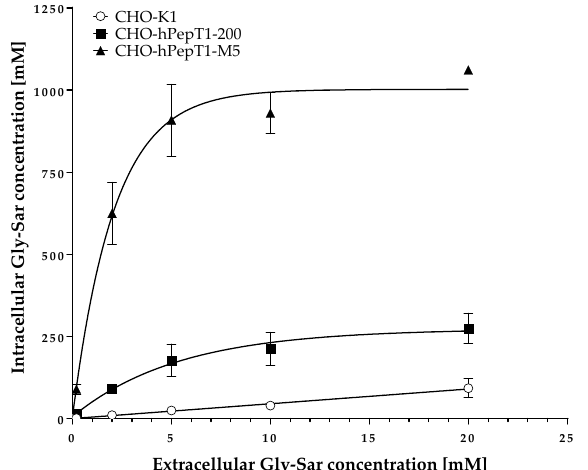
( b ) Figure 4. Concentration-dependent inhibition of the Gly-Sar uptake in the CHO-hPepT1-M5 ( a ) and the CHO-hPepT1-200 ( b ) clone by losartan. The data points represent the mean ± S.E.M. of three independent experiments with each concentration tested in sextuplets. Therefore, we used the M5 clone for all subsequent experiments and verified its PepT1 activity via inhibition with a second inhibitor (Gly-Pro). As observed with losartan, Gly-Pro inhibited the Gly-Sar uptake in CHO-hPepT1-M5 cells concentration-de- pendently (IC 50 = 196 ± 41 µM; Figure 5) and confirmed that the M5 clone expresses func- tional hPepT1.